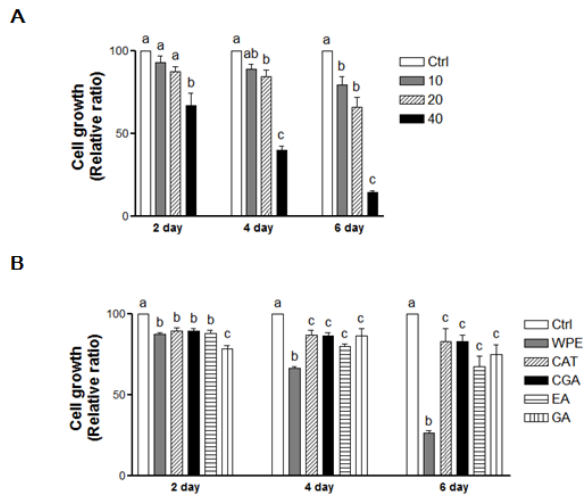
Figure 2. WPE and its bioactive compounds suppress the cell proliferation of colon CSCs. CD133 + CD44 + HCT116 cells were treated with varying concentrations of WPE (0, 10, 20, and 40 µ g/mL) ( A ); or concentrations of (+)-catechin, chlorogenic acid, ellagic acid and gallic acid comparable to 40 µ g/mL of WPE ( B ). After 2, 4 and 6 days, cell growth was analyzed using MTT assays. The values shown are the means ˘ SEM derived from 6 replicate wells. A p -value < 0.05 was considered significant. Ctrl, Control; WPE, walnut phenolic extract; CSCs, cancer stem cells; CAT, (+)-catechin; CGA, chlorogenic acid; EA, ellagic acid; GA, gallic acid.